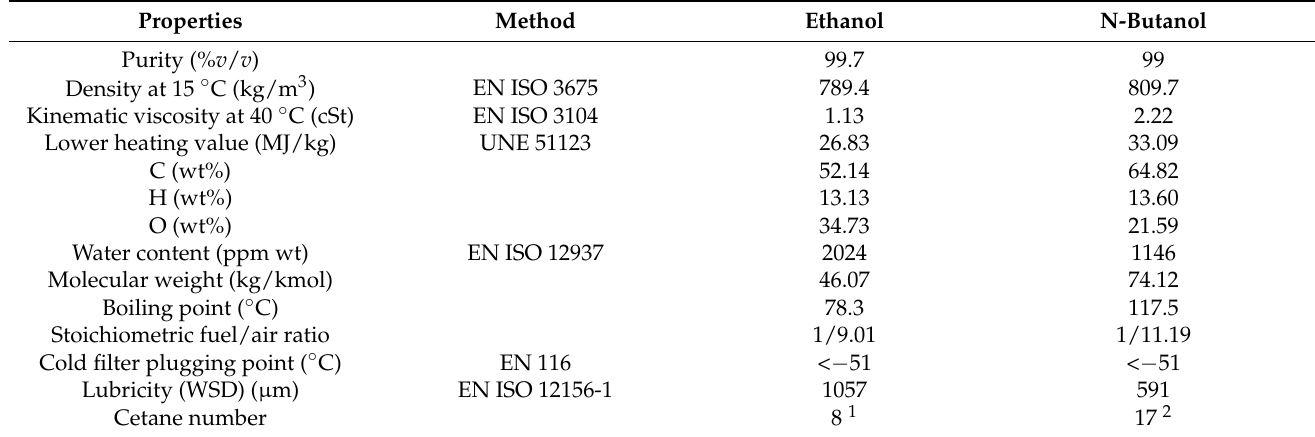
Table 1. Summary of ethanol and n-butanol properties